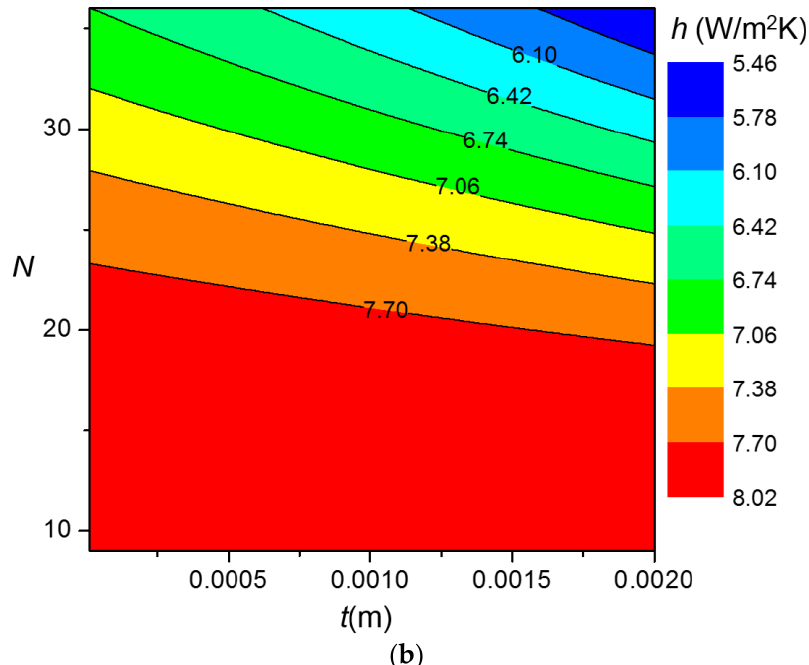
Figure 10. Contour maps of ( a ) effective surface area and ( b ) heat transfer coefficient for various fin numbers and fin thicknesses ( H = 30 mm, D = 60 mm, L = 50 mm, α = 60°, T w − T amb = 50 °C, k f = 0.026 W/m K, k s = 220 W/m K, ν f = 1.6 ˆ 10 ´ 5 m 2 /s, α f = 2.23 ˆ 10 ´ 5 m 2 /s, β f = 0.0033/K).